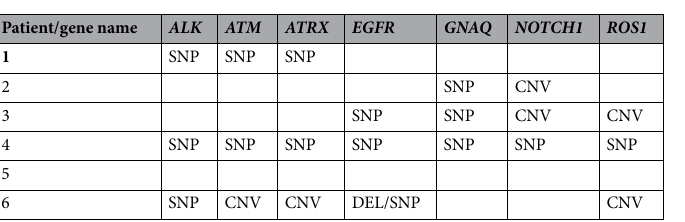
Table 3. Genes alterations detected at high frequencies among the six patients. SNP single nucleotide polymorphism, CNV copy number variation, DEL